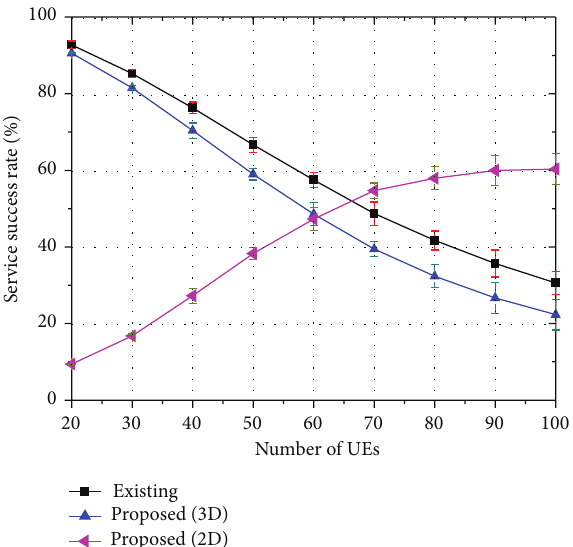
Figure 7: Service success rate of 8-viewpoint 3D A/V traffic ( 𝛽 = 0.45 ).